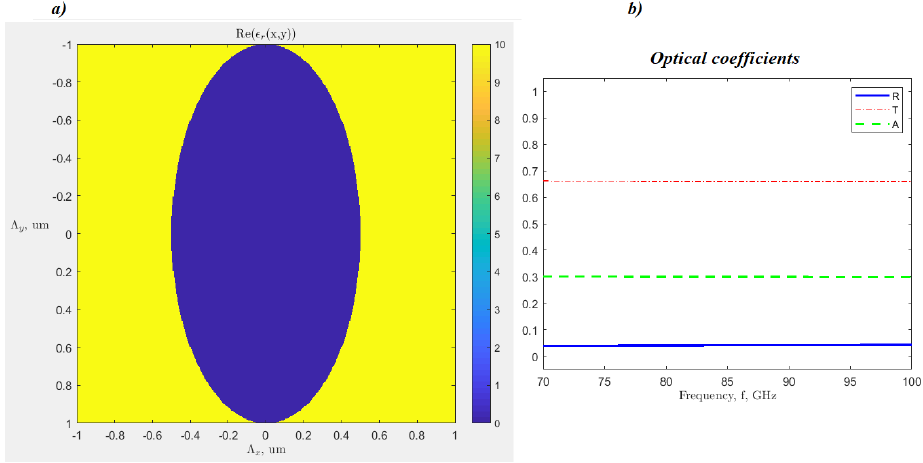
Fig. 3. Metallized surface consisting of periodically arranged intersecting elliptical conductive particles: a – unit cell dielectric constant plot, b – optical coefficients plot.